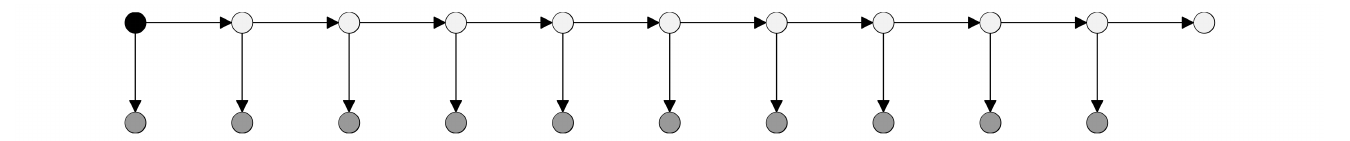
Figure 10. Relevant states and transitions when trying to get new